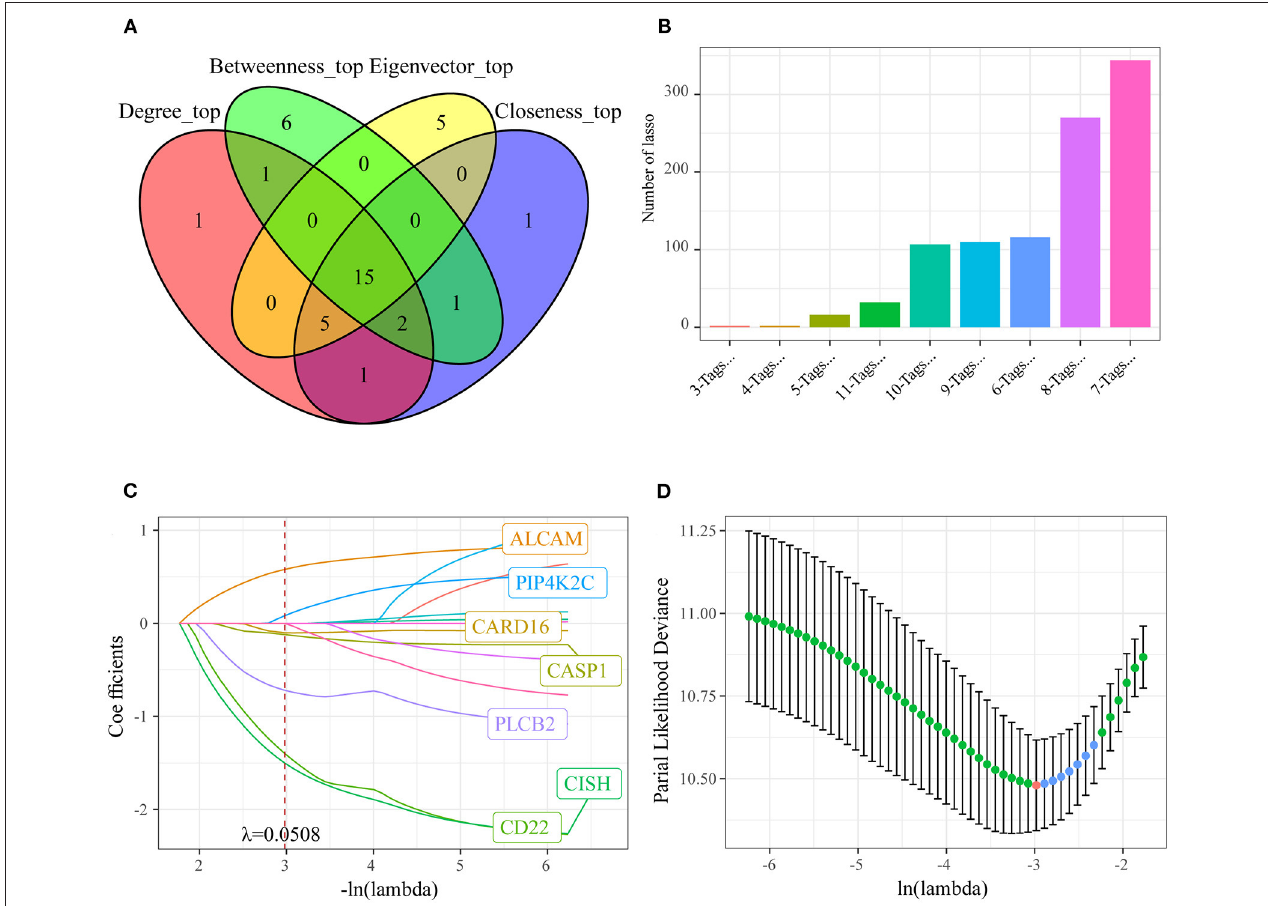
FIGURE 5 | Identifying the prognosis signature related to oxaliplatin resistance for colon cancer by least absolute shrinkage and selection operator (LASSO). (A) Fifteen genes whose values of all the above four parameters were greater than or equal to the median of all nodes were selected as the key prognostic markers related to the resistance of colon cancer to oxaliplatin. (B) Frequency of different gene combinations in a thousand times of LASSO regressions. (C) The changing trajectory of each independent variable. The horizontal axis represents the log value of the independent variable lambda, and the vertical axis represents the coefficient of the independent variable. When lambda = 0.0508, the coefficients were not 0 in seven genes. (D) Confidence intervals for each lambda. We chose the lambda with the smallest average standard deviation as the optimal model, that is, lambda =